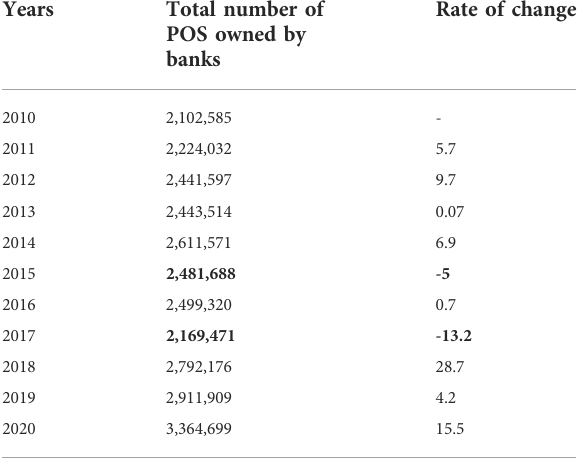
TABLE 8 Total amount of savings deposits of banks during 1998 – 2020.